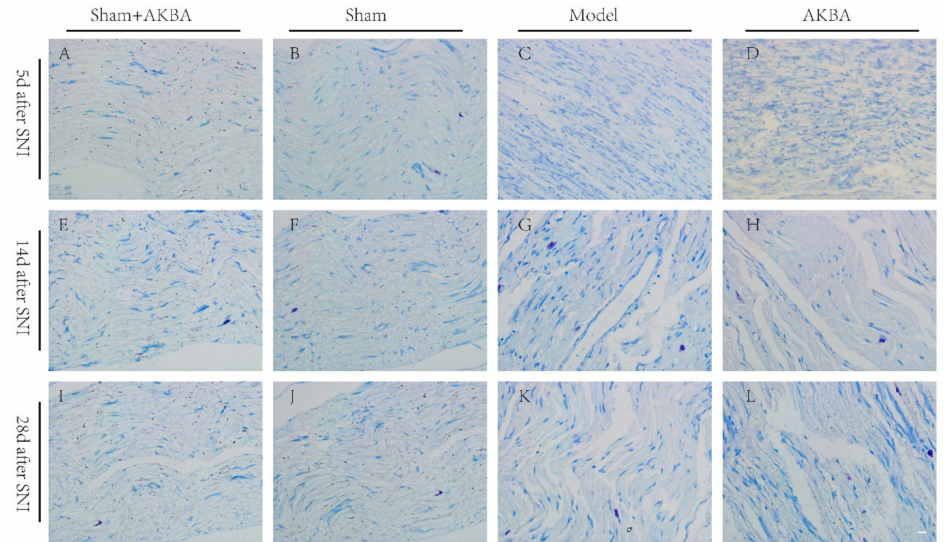
Figure 2. Toluidine blue staining of the sciatic nerve in each group at different time points. ( A – D ) Toluidine blue staining of the sciatic nerve in each group 5 d after injury. ( E – H ) Toluidine blue staining of the sciatic nerve in each group 14 d after injury. ( I – L ) Toluidine blue staining of the sciatic nerve in each group 28 d after injury. The scale bar of all images is 20 µ